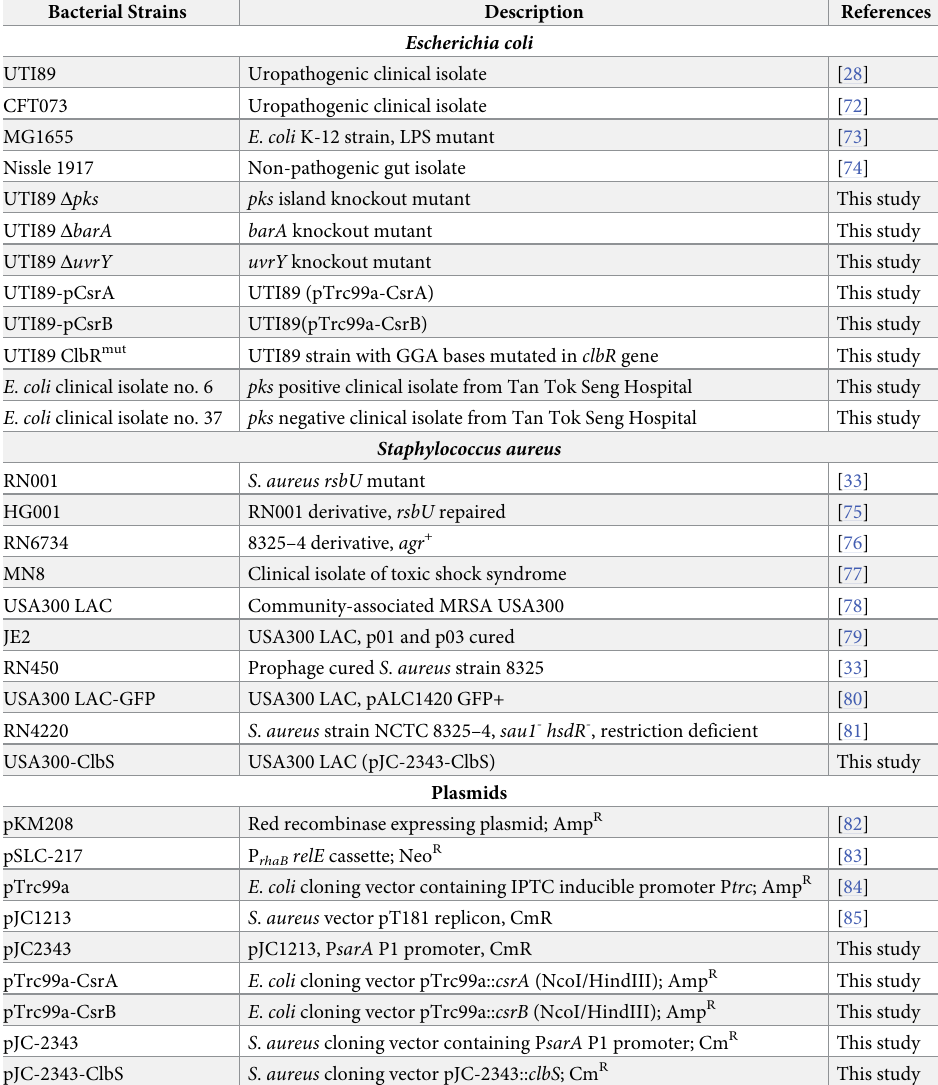
Table 1. List of bacterial strains and plasmids used in this study. Bacterial